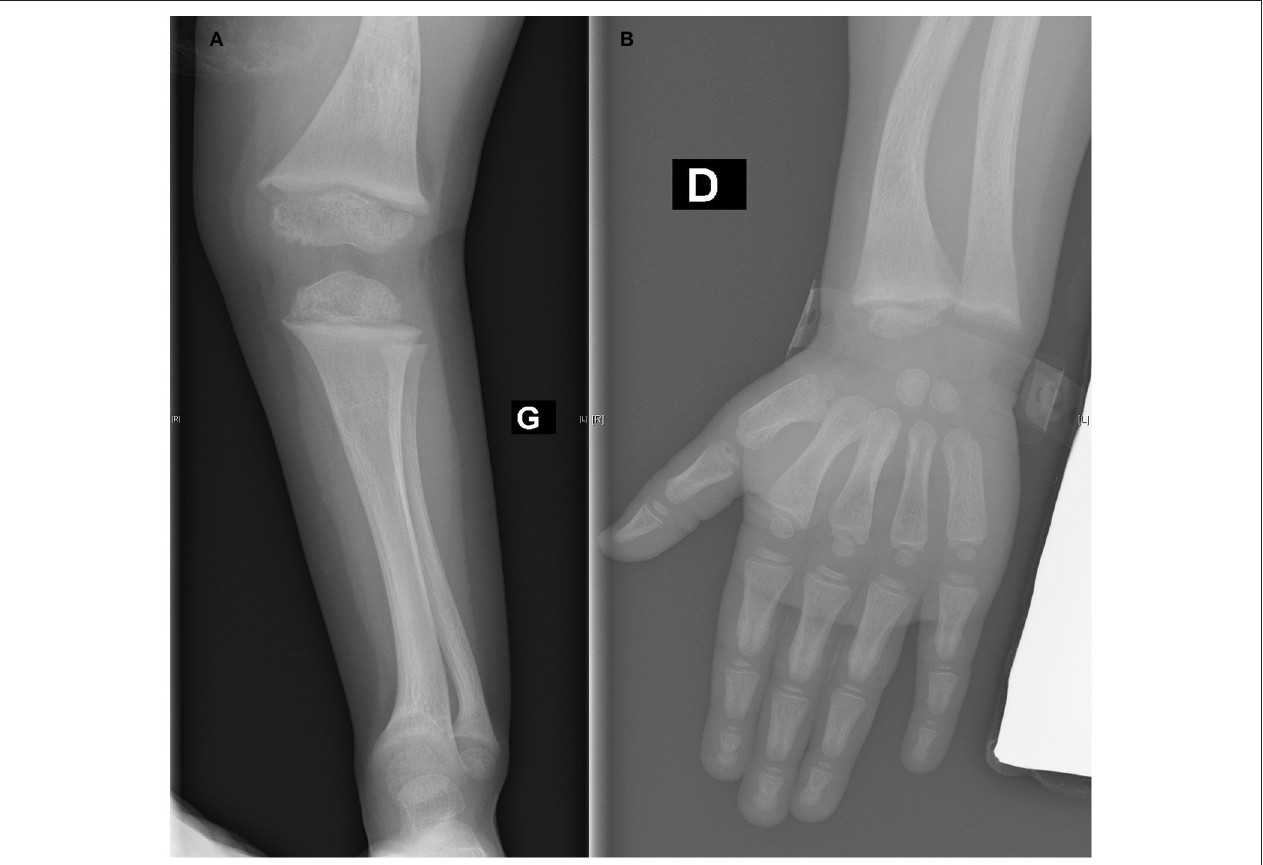
FIGURE 2 | (A,B) Healing of rachitic lesions at the lower (A) and upper (B) extremity (12 months after